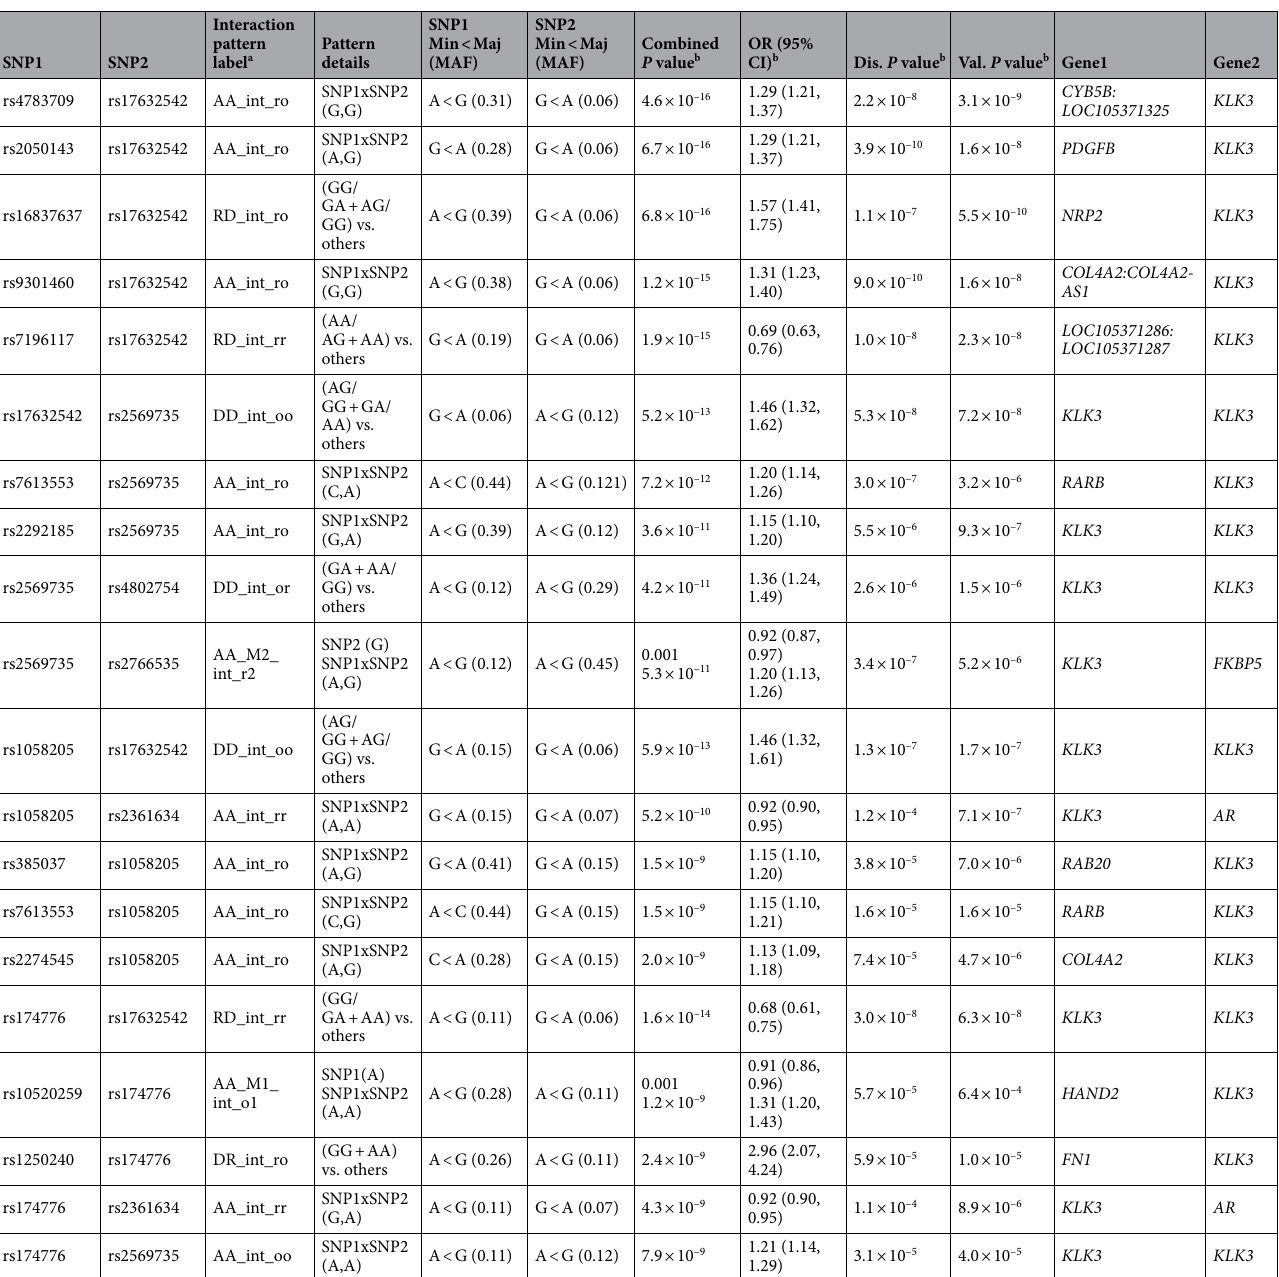
Table 2. Top 5 pairs for the four KLK3 clusters of rs2569735, rs17632542, rs1058205, and rs174776 associated with prostate cancer aggressiveness. CI confidence interval, Dis discovery set, MAF minor allele frequency, Maj major allele, Min minor allele, OR odds ratio, Val validation set. a SIPI pattern interpretation: The first 2 letters represent inheritance modes of the first SNP (or SNP1) and the 2nd SNPs (or SNP2); mode (A, additive mode; D, dominant mode; R, recessive mode; “(SNP1 mode)(SNP2 mode)_int_(SNP1 code)(SNP2 code)” is for interaction-only pattern; “M _int_”, interaction plus one main effect of SNP ; SNP code (o, original coding based on the minor allele; r, reverse coding; o1: original coding for SNP1 (SNP2 with original coding); r2: ϕ ϕ reverse coding of SNP2 (SNP1 with original coding). b For verified SNP pairs with P < 1 × 10 –5 in the combined set and p_interaction < p_individual; all models adjusted for study site and first six principal